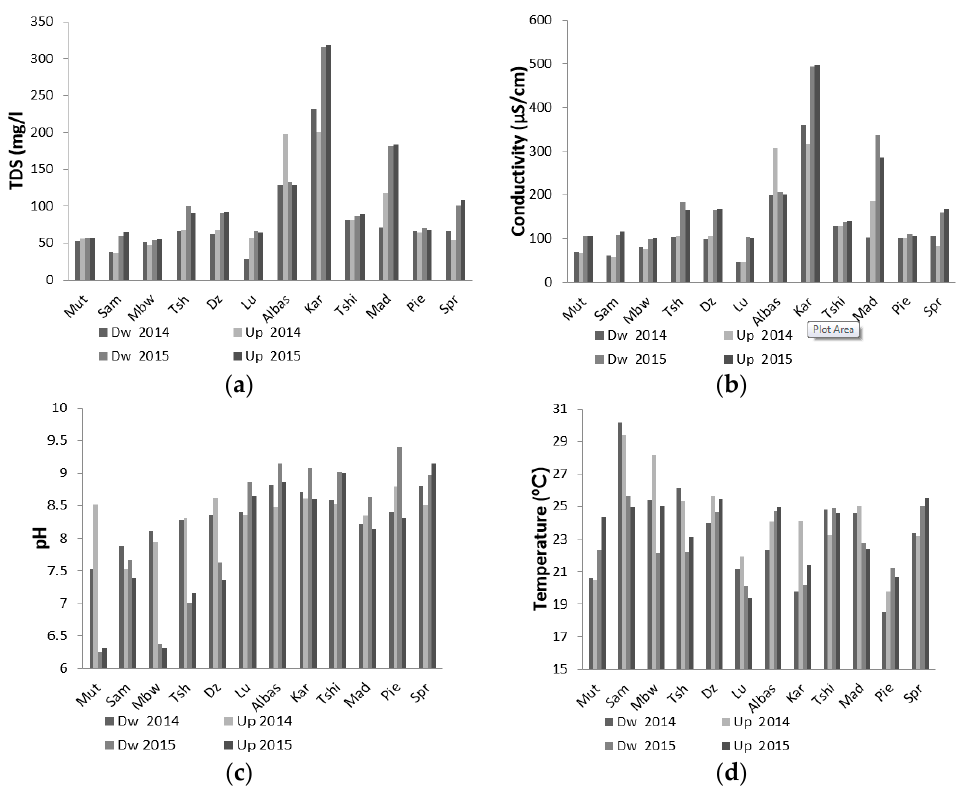
Figure 2. ( a ) Total Dissolved Solids (TDS mg/L); ( b ) Electrical conductivity (EC μ S/cm); ( c ) pH; and ( d ) Temperature (Temp °C) determined on river water samples in 2014 and 2015.